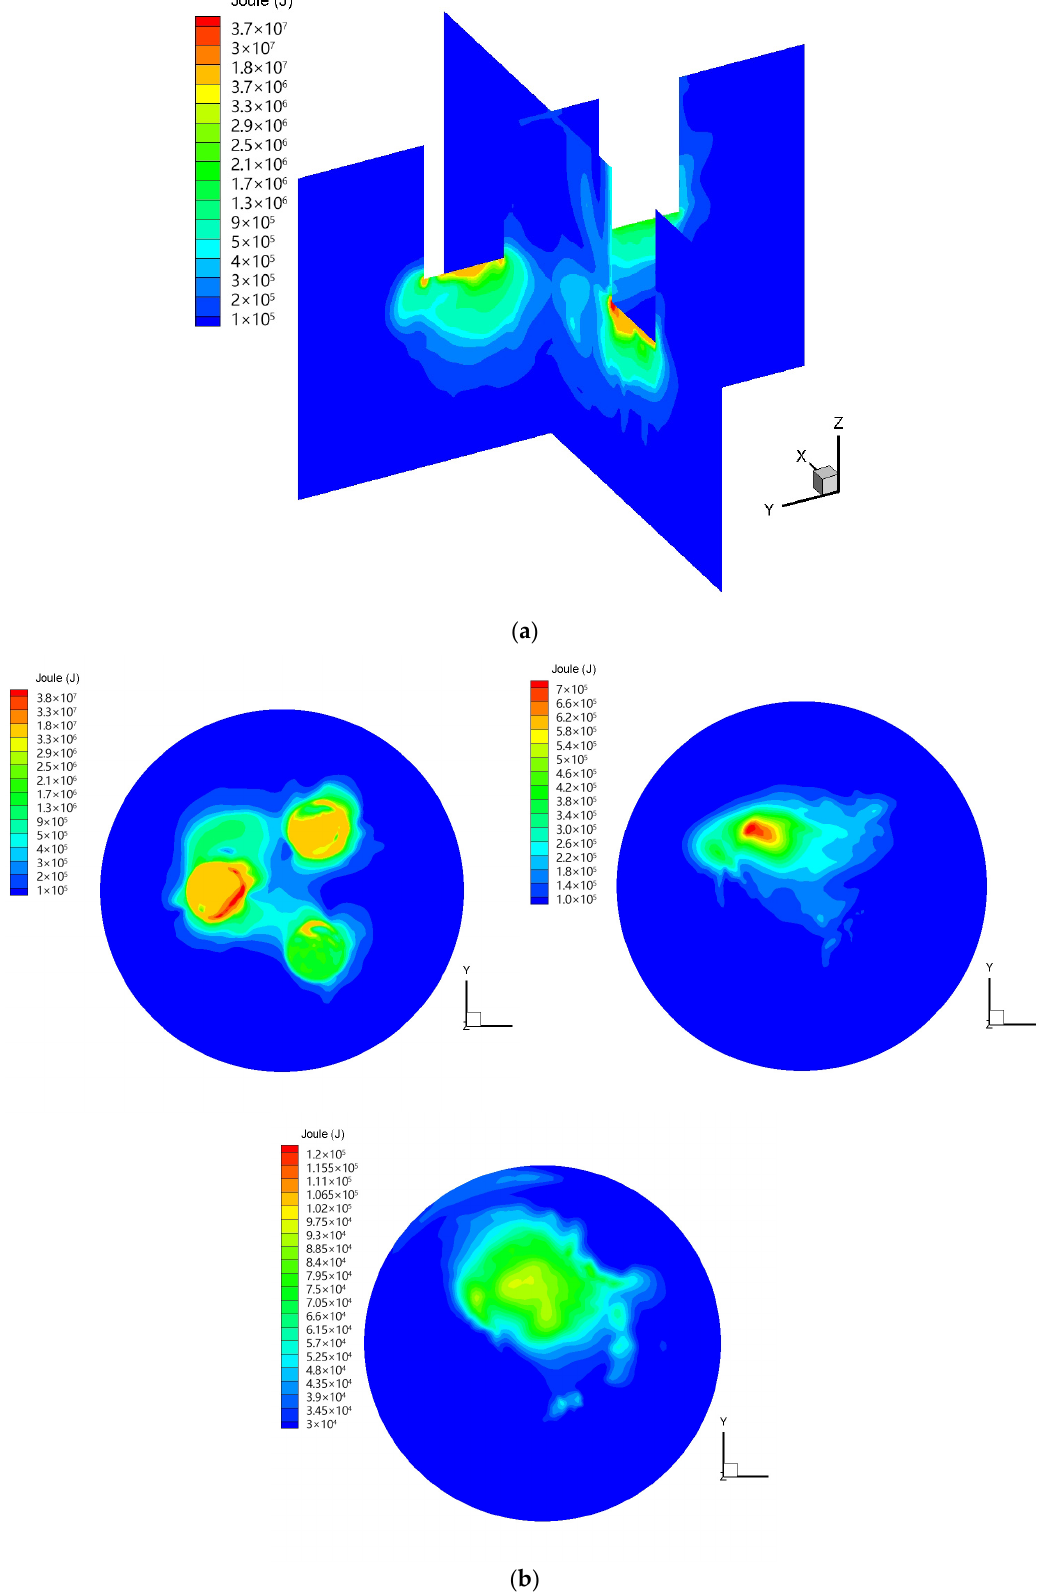
Figure 7. ( a ) Joule heat distribution (longitudinal section). ( b ) z = 0.65 m, 0.35 m, 0.15 m joule heat distributions